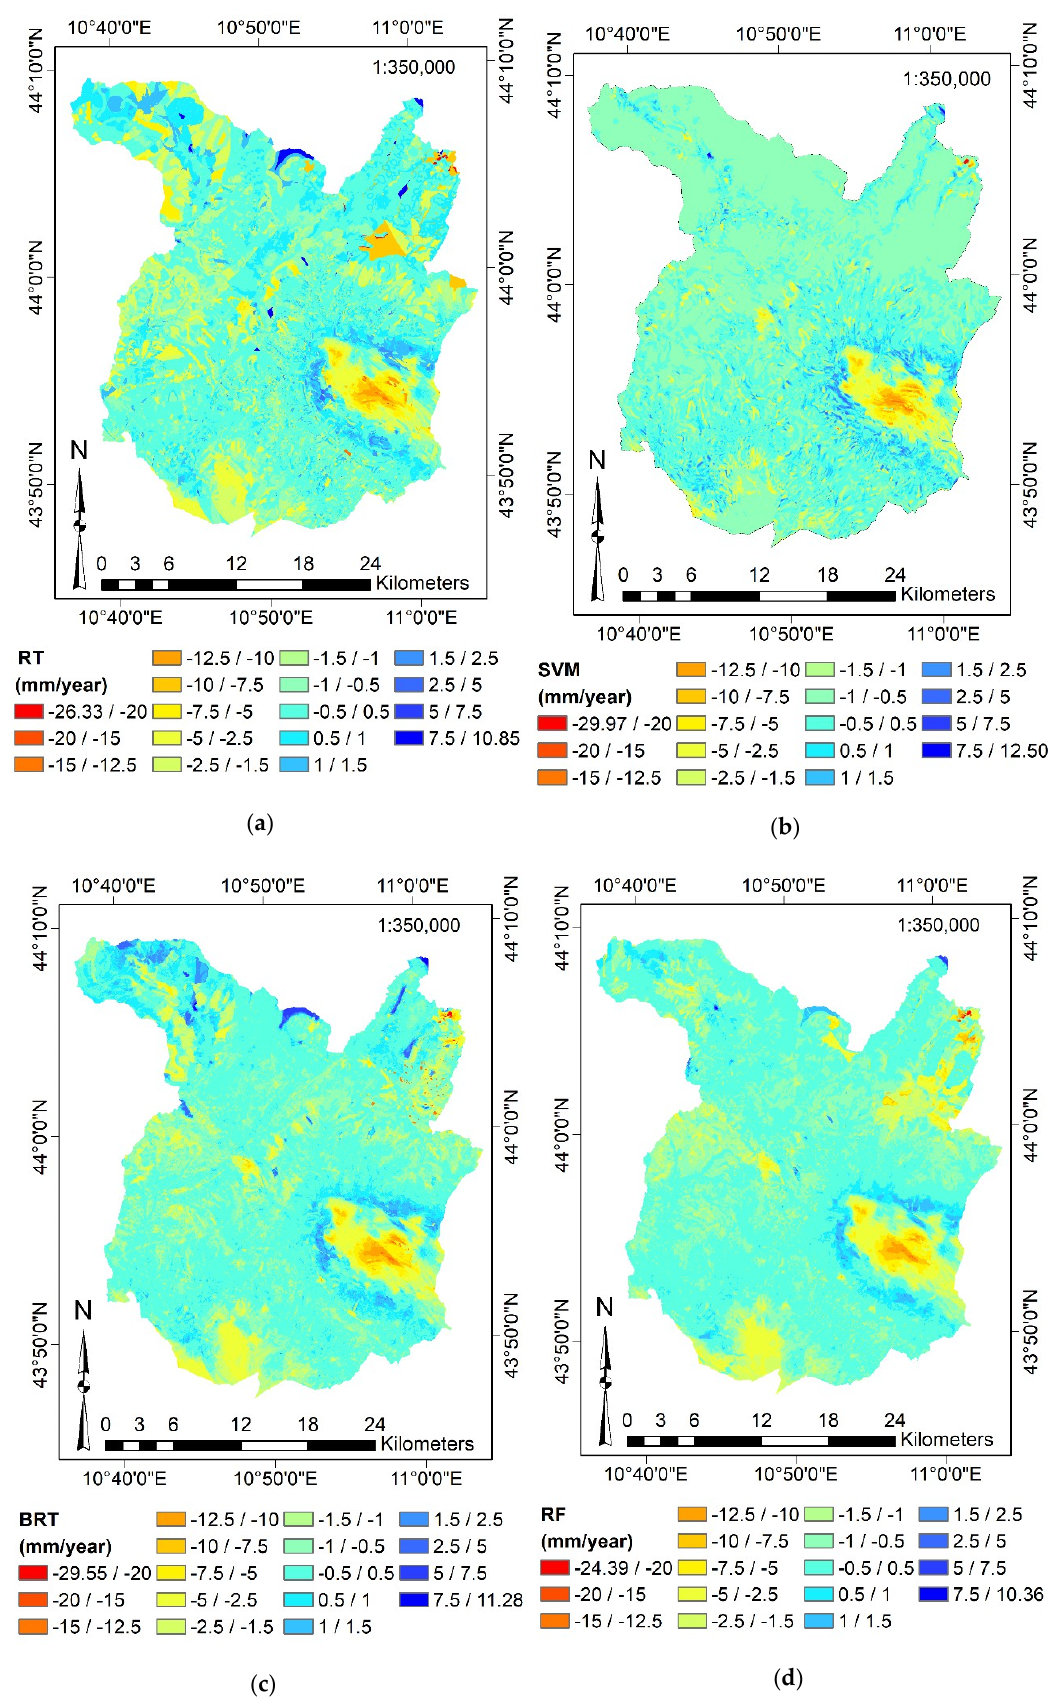
Figure 9. Surface motion mapping over the study area: ( a ) RT; ( b ) SVM; ( c ) BRT; ( d ) RF.